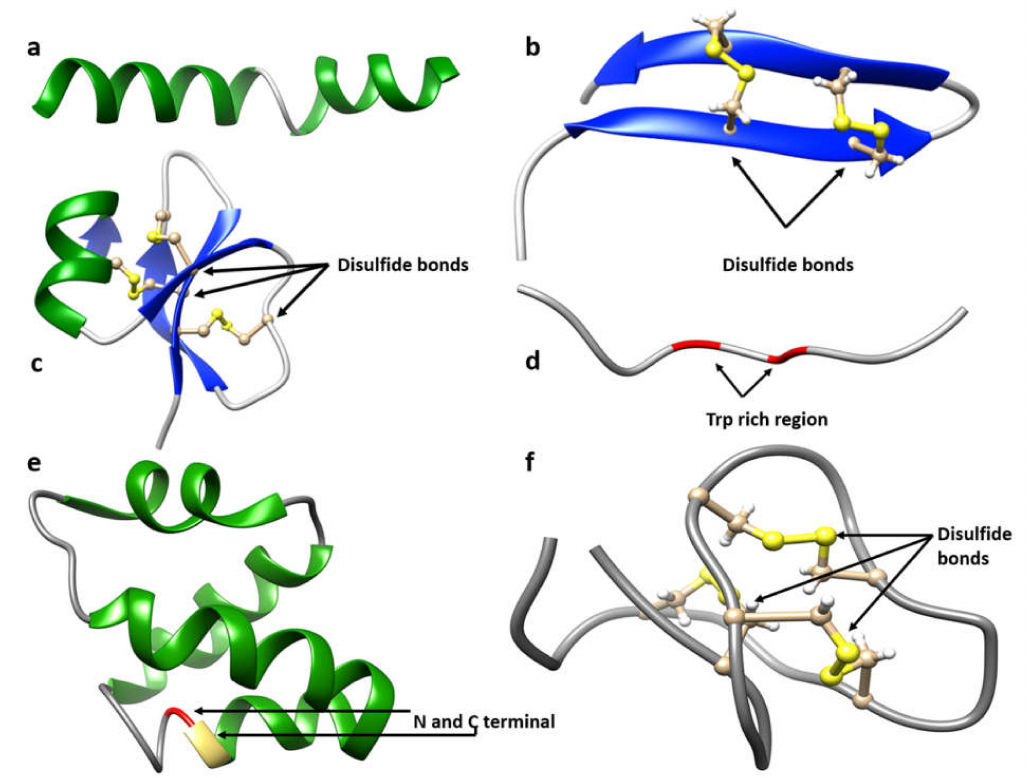
Figure 3. Representative AMPs from five structure-based classes. ( a ) α -helix AMPs (melittin, amino acid sequence GIGAVLKVLTTGLPALISWIKRKRQQ, PDB entry: 2MLT). ( b ) β -sheet AMPs (protegrin-1, amino acid